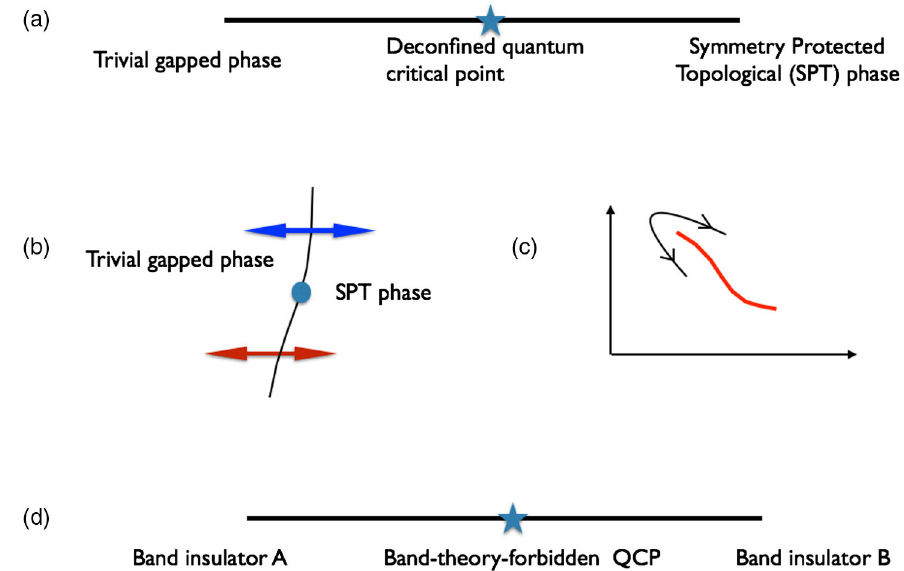
FIG. 1. (a) Deconfined quantum criticality at the trivial-to-SPT phase boundary of systems of either bosons or fermions. (b) Multiple universality classes for the same phase transition. (c) “ Unnecessary quantum critical points ” that live within a single phase of matter. (d) Band-theory-forbidden QCP between two band